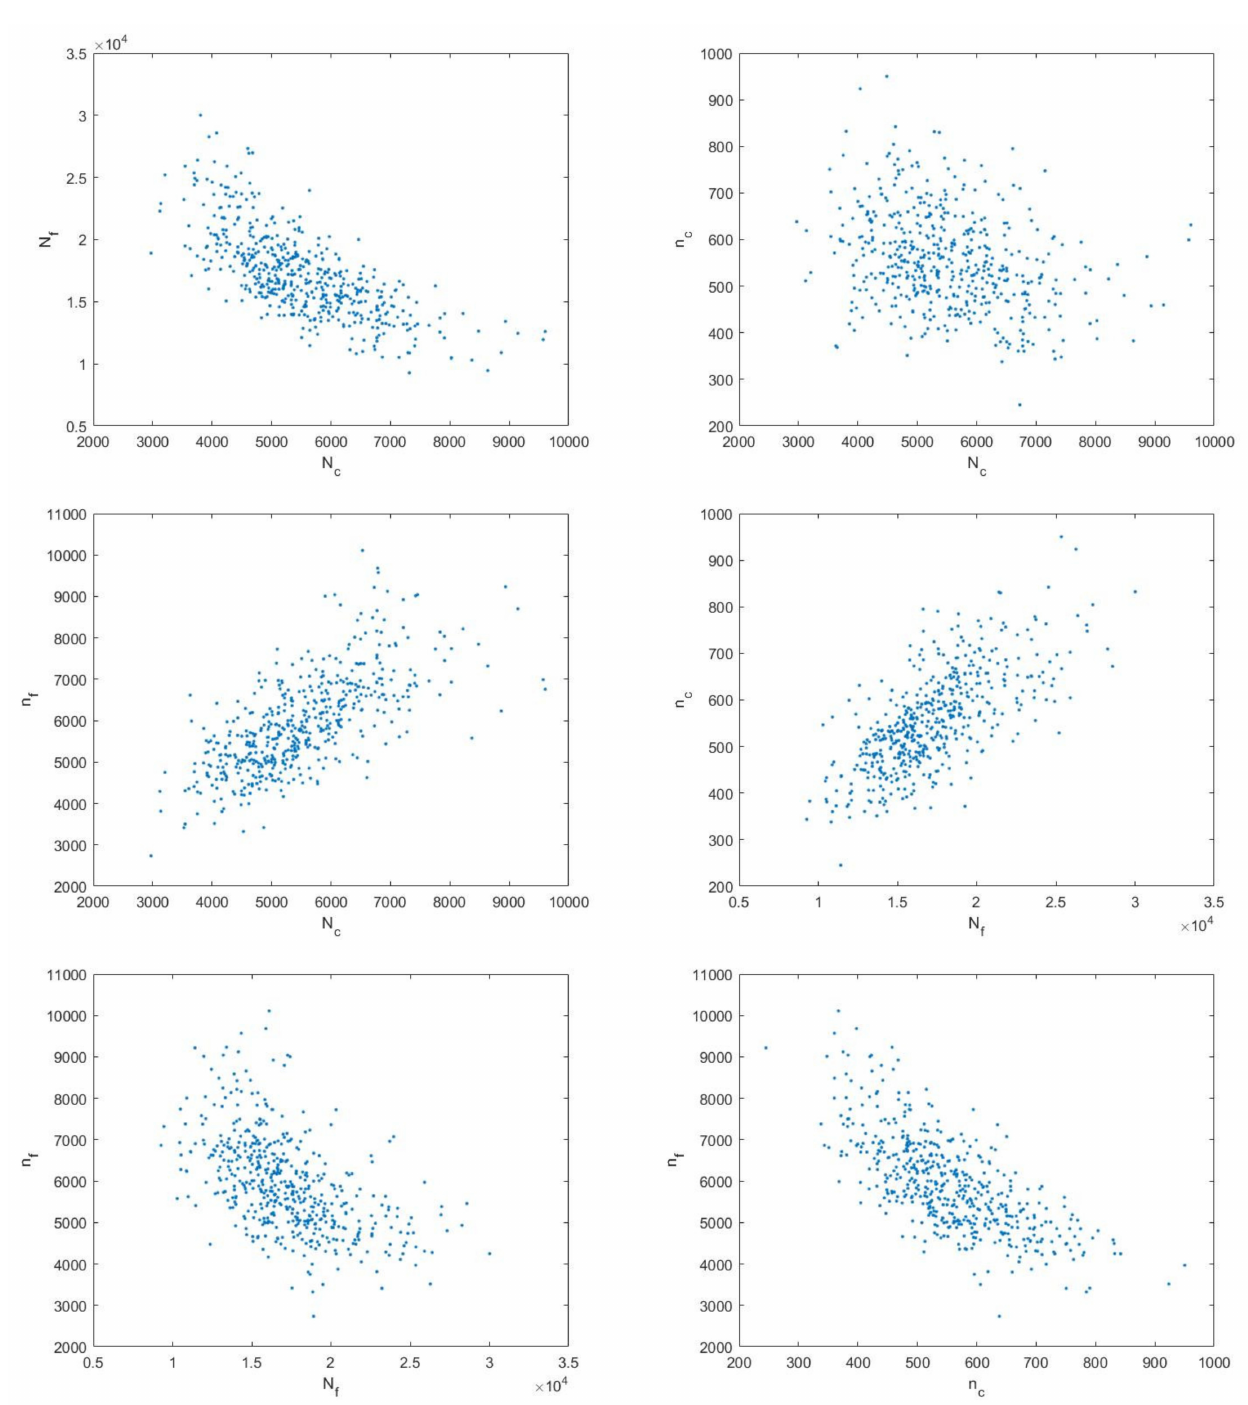
Figure 9. Sample distribution of input variables ( N =